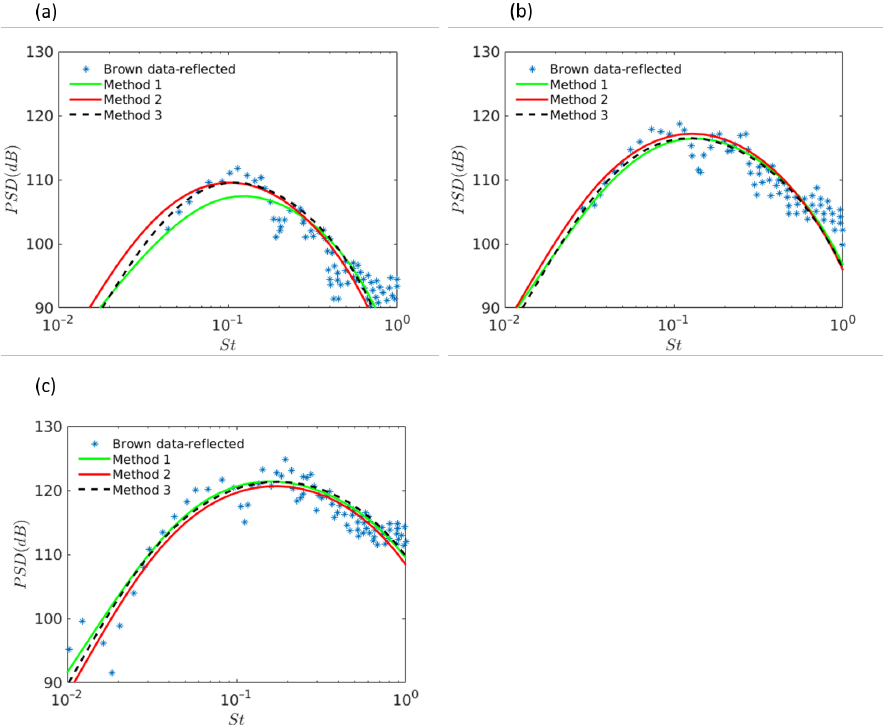
Figure 14. Comparison of the acoustic predictions for methods 1, 2 and 3 using Multi-Start ( a ) Ma = 0.5 ( b ) Ma = 0.7 ( c ) Ma =